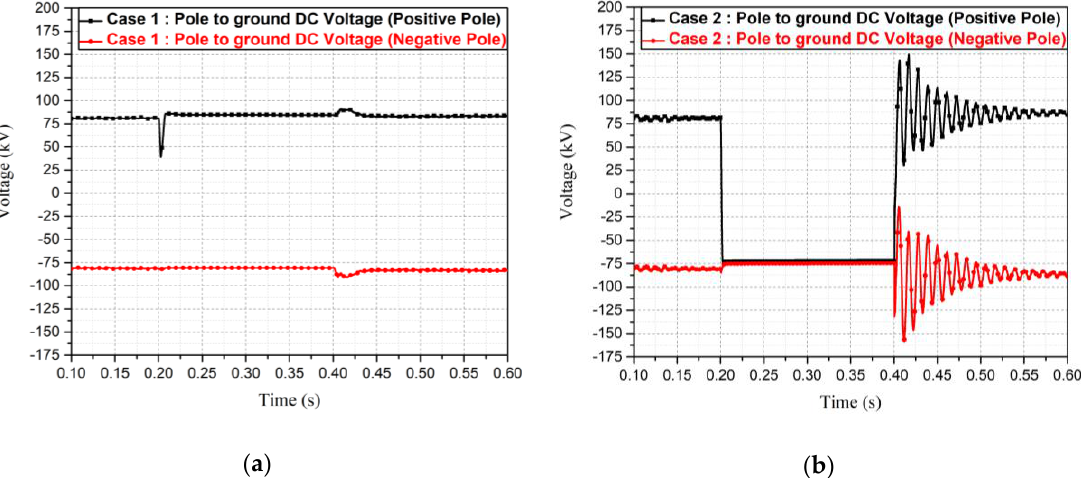
Figure 15. The waveform of pole-to-ground DC voltage in the fault and reclosing process: ( a ) Case-1; ( b ) Case-2.